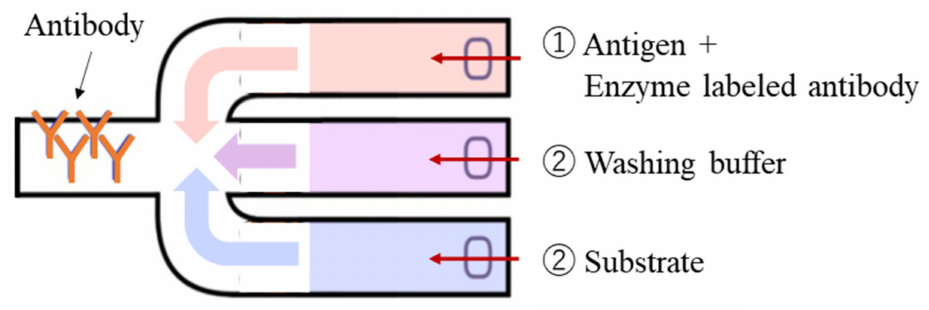
Figure 1. Schematic of an enzyme-linked immunosorbent assay (ELISA) on a µ